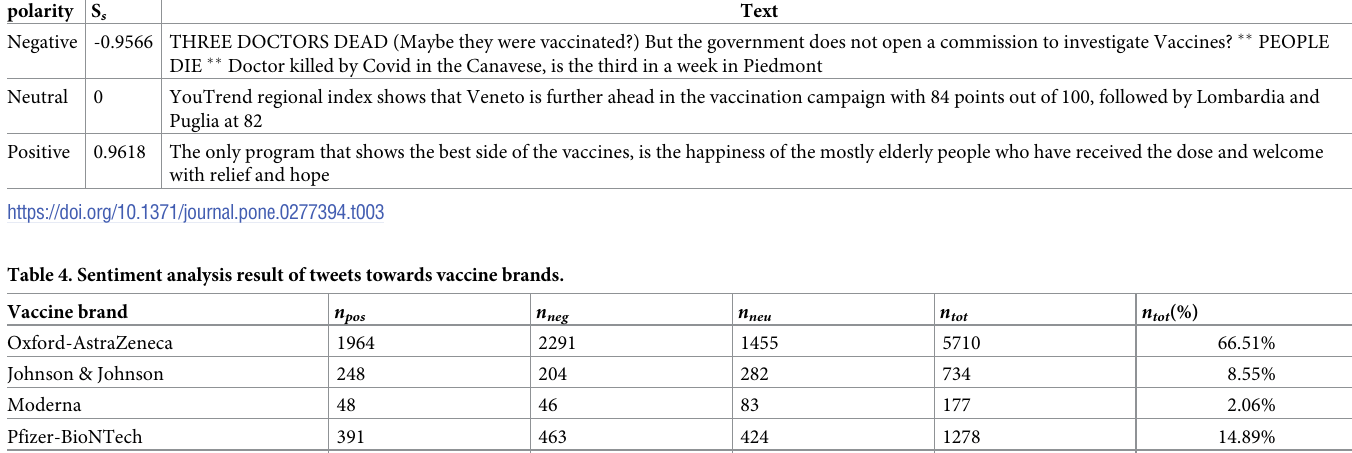
Table 3. Some examples of tweets with sentiment score (S polarity S s Text